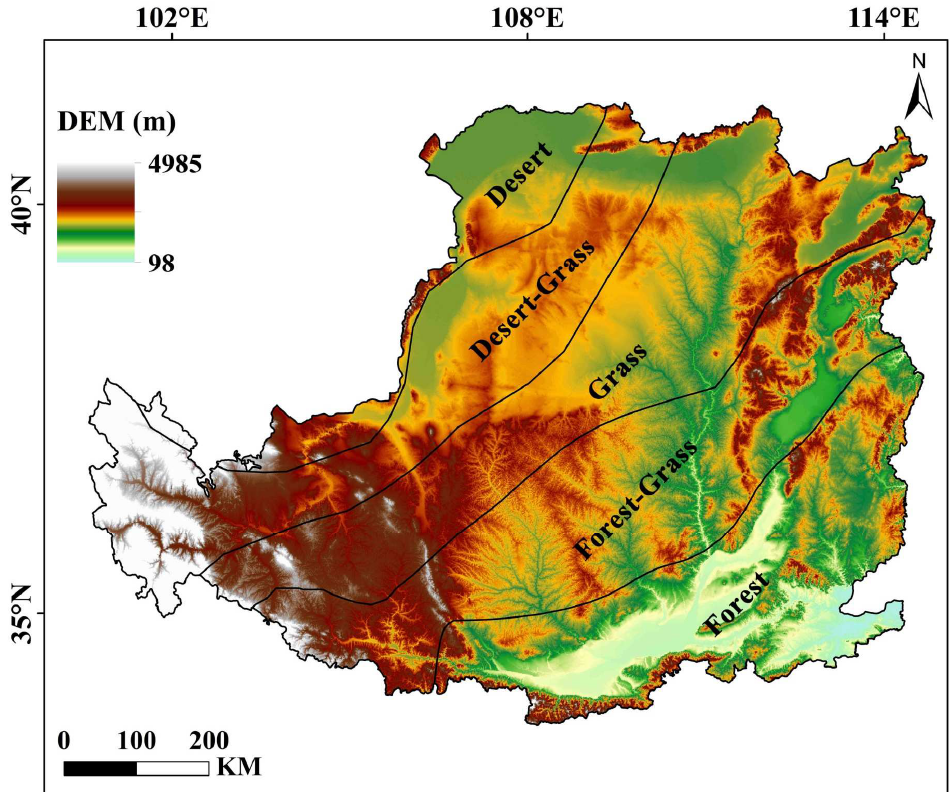
Figure 1. Map of the Loess Plateau (LP) and its bioclimatic zone division.